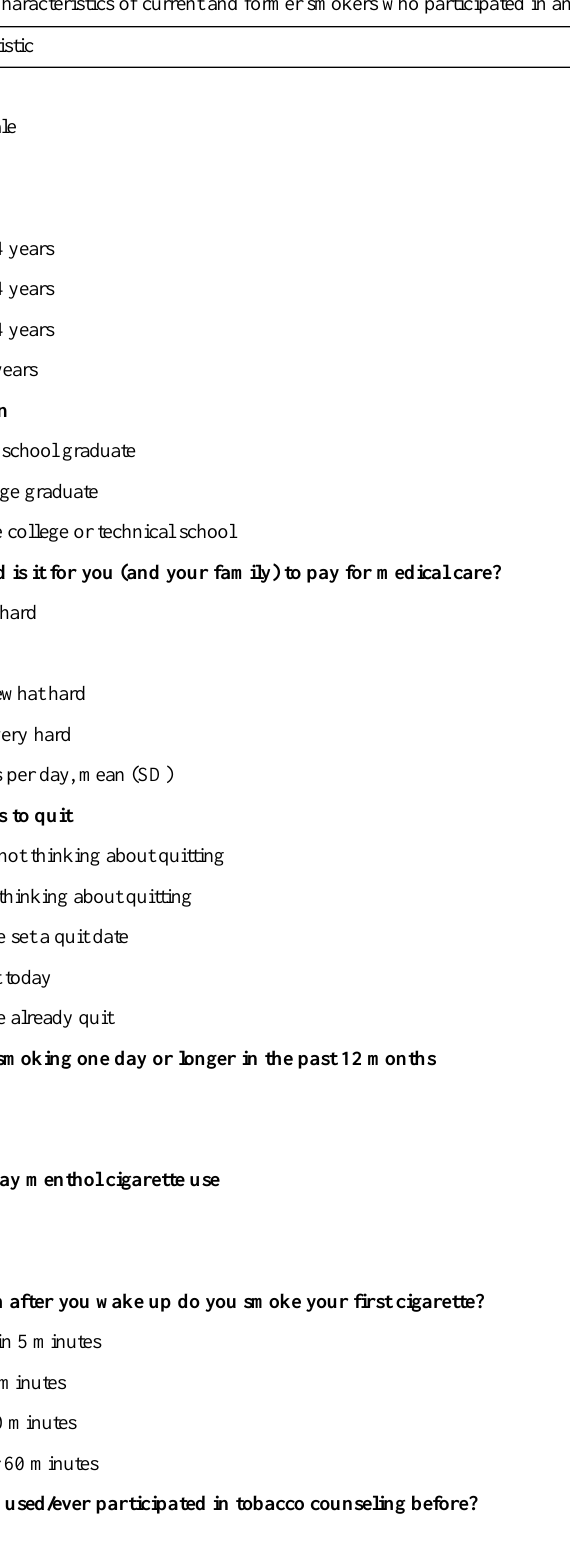
Table 1. Characteristics of current and former smokers who participated in an online study